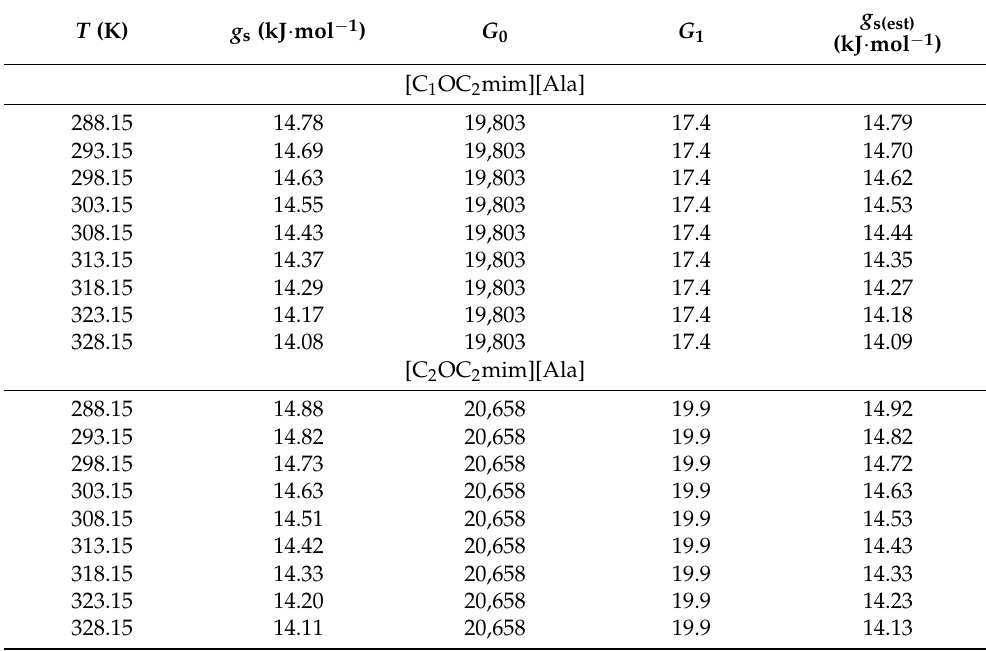
Table 2. Molar surface Gibbs energy ( g s ), G 0 , G 1 , and estimated molar surface Gibbs energy ( g s(est) ) for [C n OC 2 mim][Ala]( n = 1,